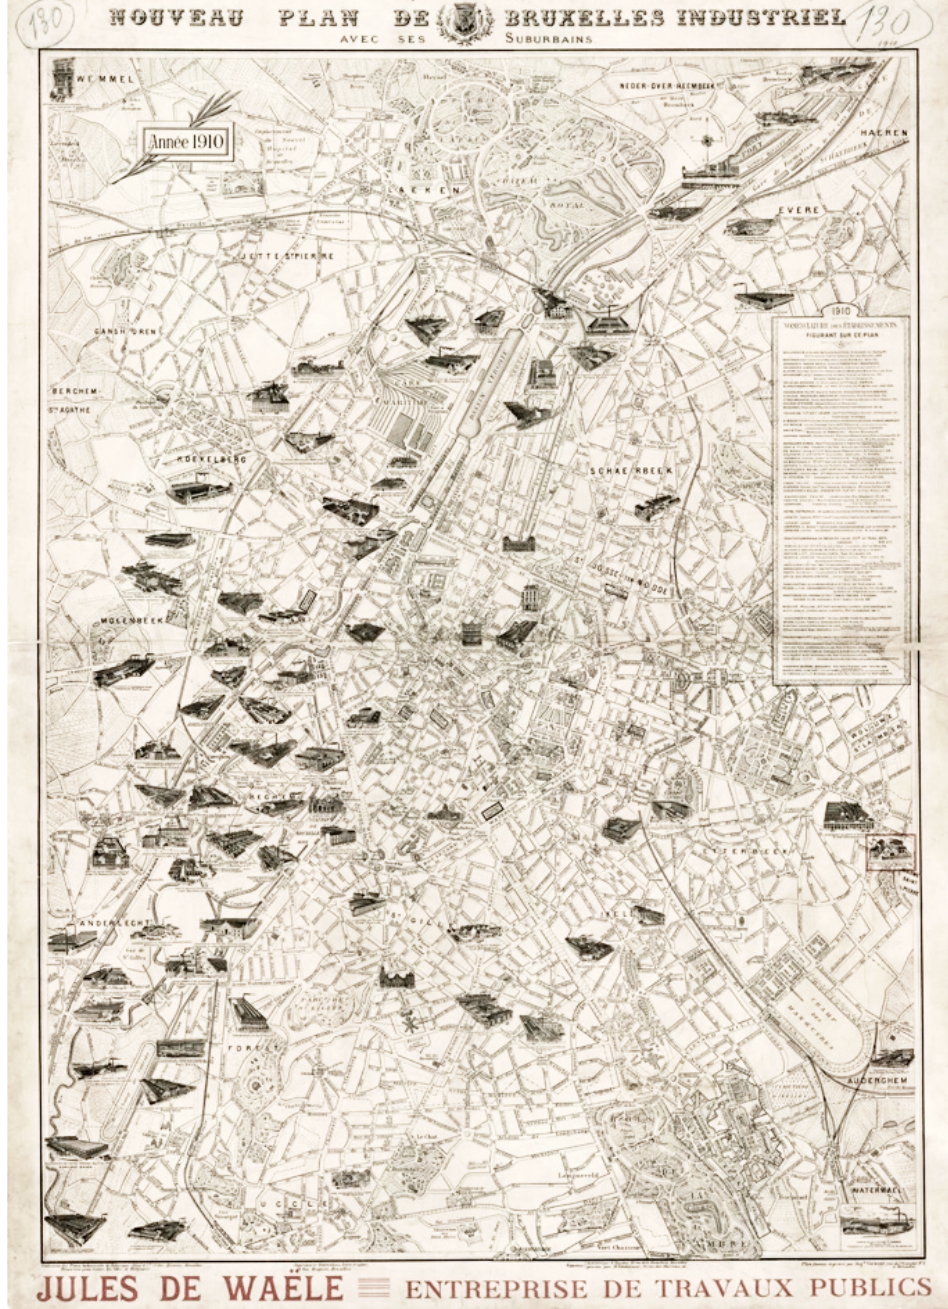
Figure 1. Plan Industriel (Verwest, Vanderoost, & Xhardez, 1910a). Courtesy of the Archives de la Ville de Bruxelles (plan de Bruxelles no. 130, section